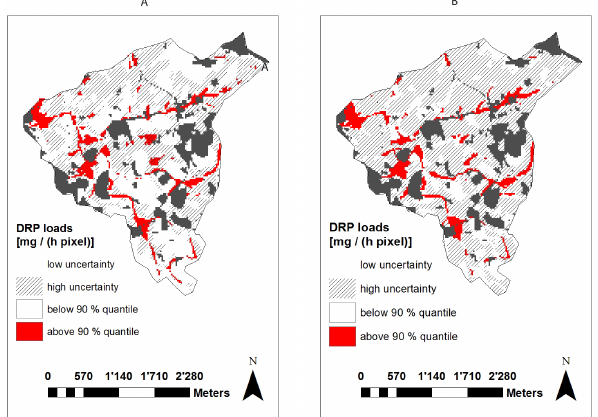
Fig. 7. Simulated distribution of DRP loads in the Stägbach catch- ment during the large event in June 2010 obtained by averaging over all Monte Carlo simulations. Red color shows the area (10% of the total agricultural area) where according to the simulations more than 50% of the total DRP loss occurred. Areas for which less than 80% of the simulations resulted in the same distribution of fast flow generation are hatched. Grey shading denotes forested and urban areas.